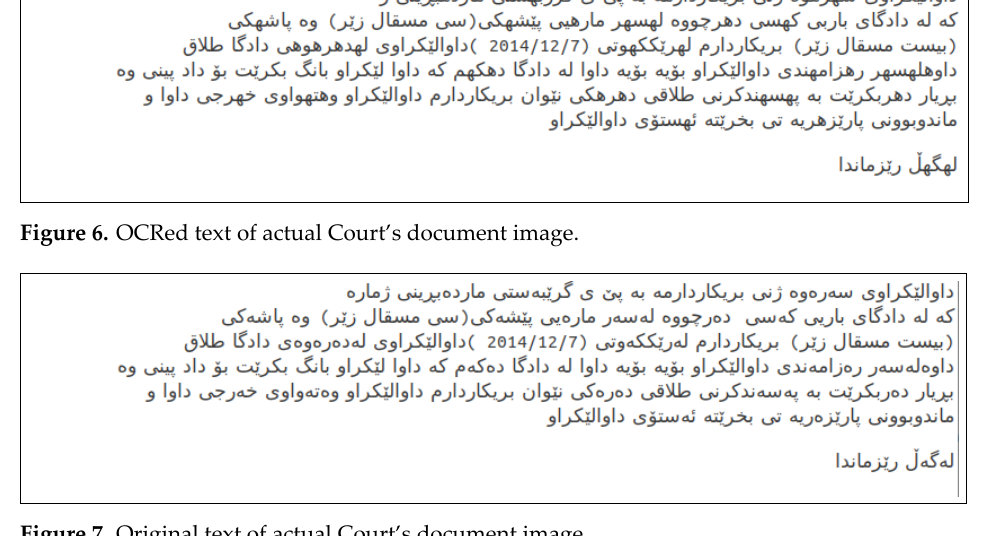
Figure 7. Original text of actual Court’s document